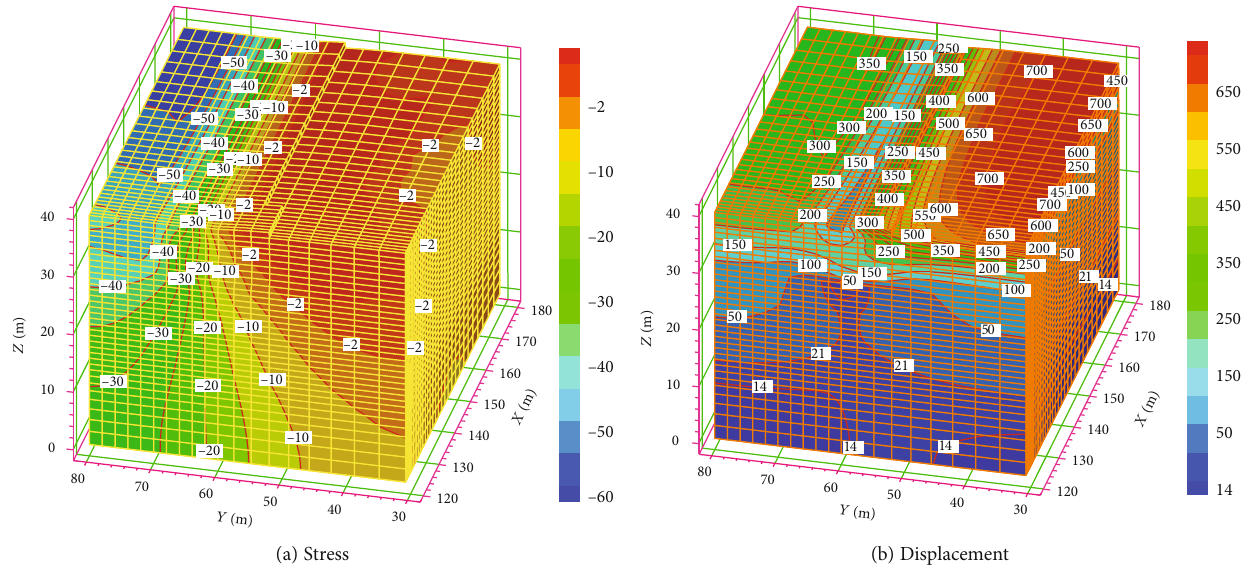
Figure 21: Distribution law of stress and displacement of surrounding rock after mining.